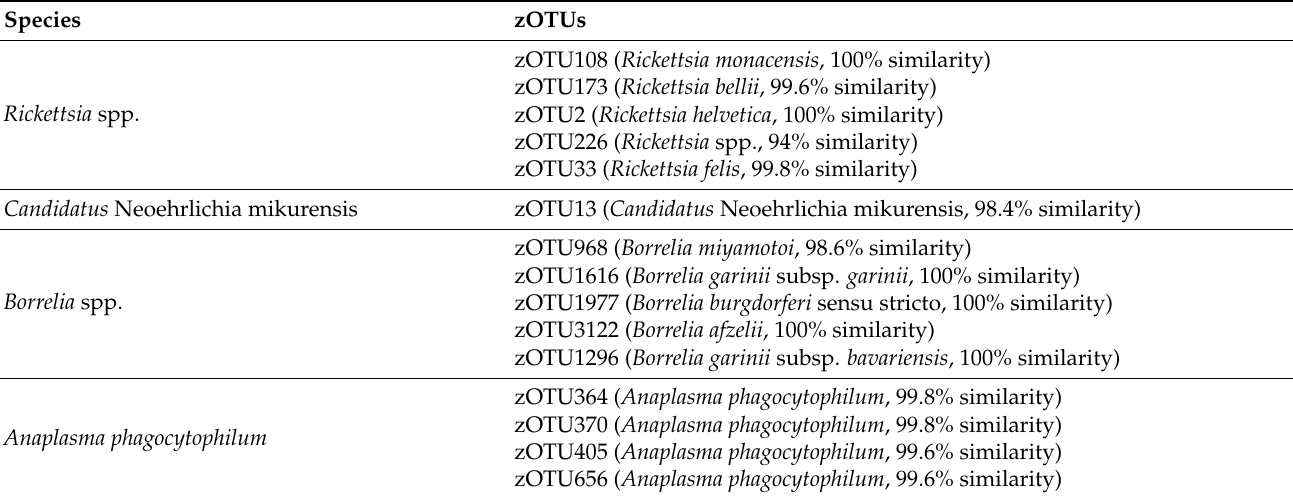
Table 3. Probable pathogenic species detected in Ixodes ricinus ticks and their assigned zOTUs. Species zOTUs